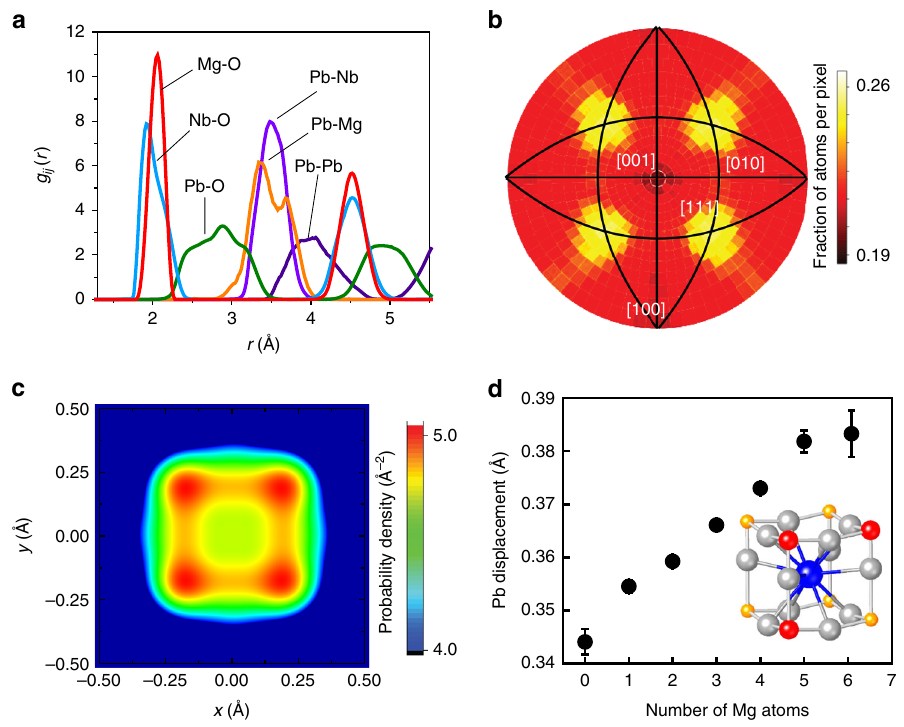
Fig. 3 Characteristics of the cation displacements. a Key partial pair-distribution functions for the re fi ned PbMg 1/3 Nb 2/3 O 3 con fi guration. The Nb – O and Pb – O peaks are split, suggesting off-centering of the respective cations. In contrast, the Mg – O distribution exhibits a single symmetric peak. b A stereographic-projection map of the Pb displacements demonstrating their preference for the 〈 111 〉 directions. (The black lines indicate traces of the {110} planes). c A slice (at z ≈ 0.17 Å) of the probability density distribution for the Pb atoms revealing the four maxima offset along the 〈 111 〉 directions. d Magnitude of the Pb displacements as a function of the local Mg/Nb ratio around Pb. The inset illustrates the [PbO 12 (Mg/Nb) 8 ] coordination. Pb, O, Mg, and Nb species are represented by the blue, light gray, red, and yellow spheres, respectively. The error bars represent single standard deviations estimated by analyzing three independently re fi ned con fi